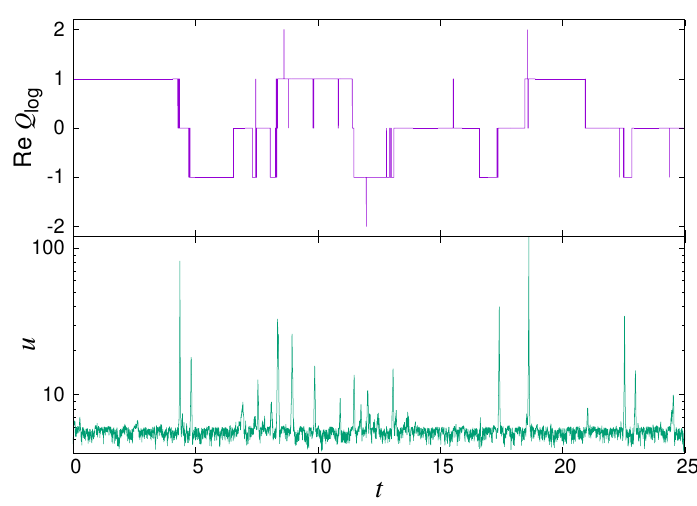
Figure 3 . The results obtained by the CLM for the non-punctured model with the sine de(cid:12)nition Q sin for ( (cid:12); L ) = (3 ; 10) with (cid:18) = (cid:25) . The upper plot shows the history of the topological charge Q log with the log de(cid:12)nition, whereas the lower plot shows the history of the magnitude u of the drift term in the log